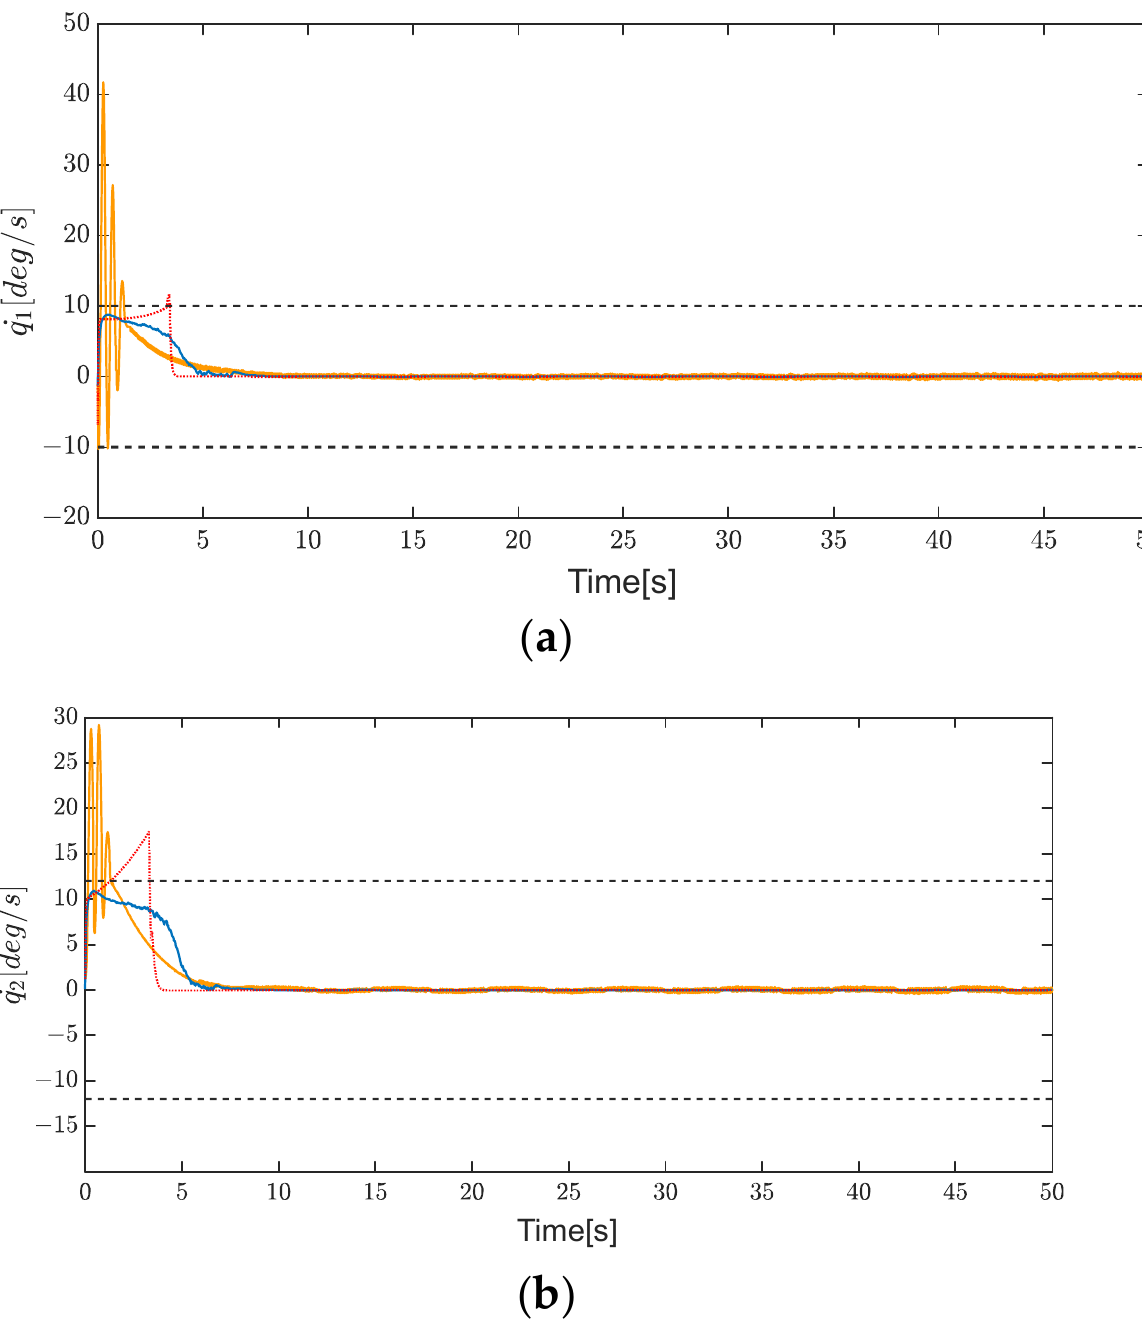
Figure 14. Comparison of angular velocity to [26,33] in case 2: the [26] scheme (yellow solid line), the [33] scheme (red dash line), the proposed scheme (blue solid line), the angular velocity con- strains (black dashed line); ( a ) Joint 1. ( b ) Joint 2.